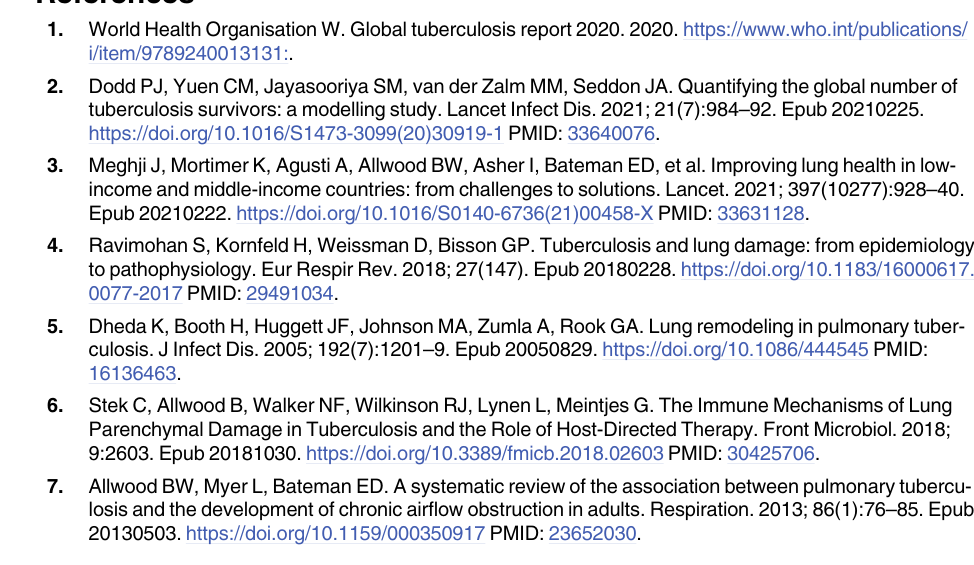
S1 Table. Search terms used for systematic review on post-tuberculosis lung disease in low- and middle-income